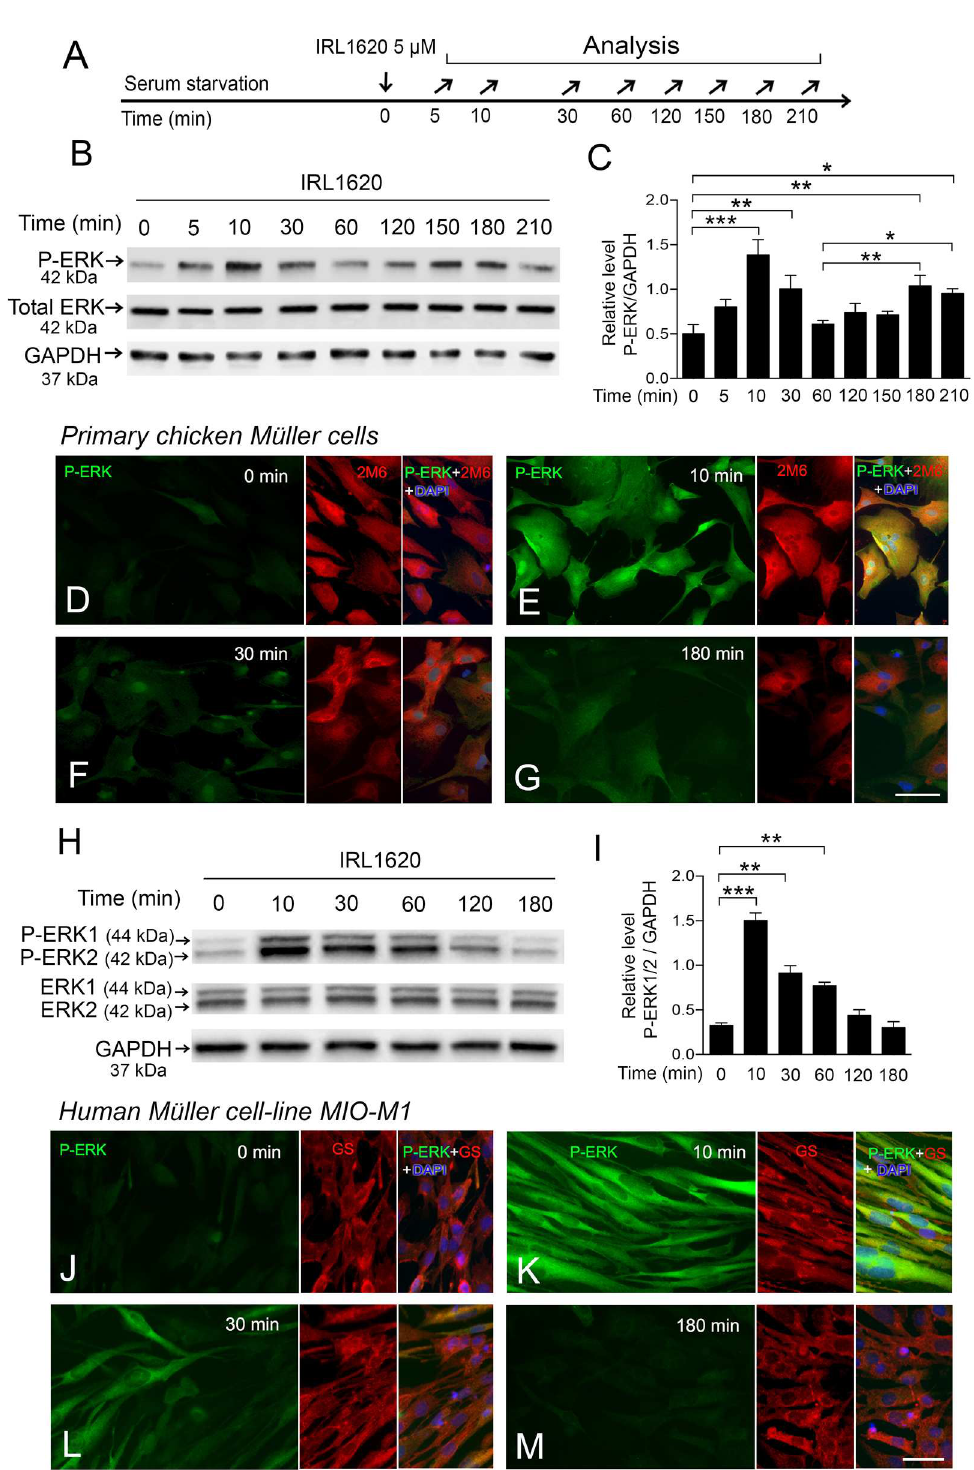
Fig 4. P-ERK1/2 in primary chicken Mu¨ller cells and the human MIO-M1 cell line after stimulation with IRL1620. (A) Experimental outline. (B-G) Primary chick Mu¨ller cells and (H-M) humanMIO-M1 cells. Serum- starved cells were treated with 5 μ M IRL1620,and analyzedat 5 min up to 210 min. (B) Western blot analysisof P-ERK levels in IRL1620-treated primary chick Mu¨ller cells. (C) Bar graph with densitometry of P-ERK levels normalized by GAPDH levels. Normalization to total ERK showed similar results (S5 Fig). Note that western blot analysisfor ERK1/2 only shows one band in contrast to the two bandsthat are seen in mammals.